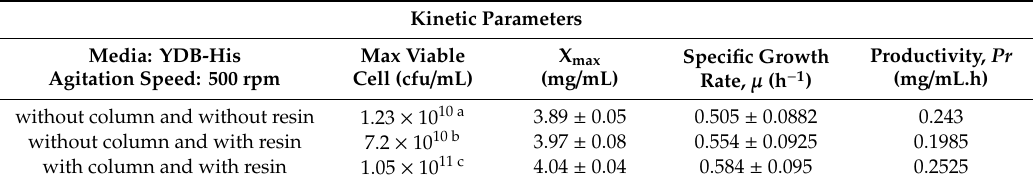
Table 2. E ff ect of culture gdhA derivative P. multocida B:2 with column and with resin in a 2 L stirred-tank